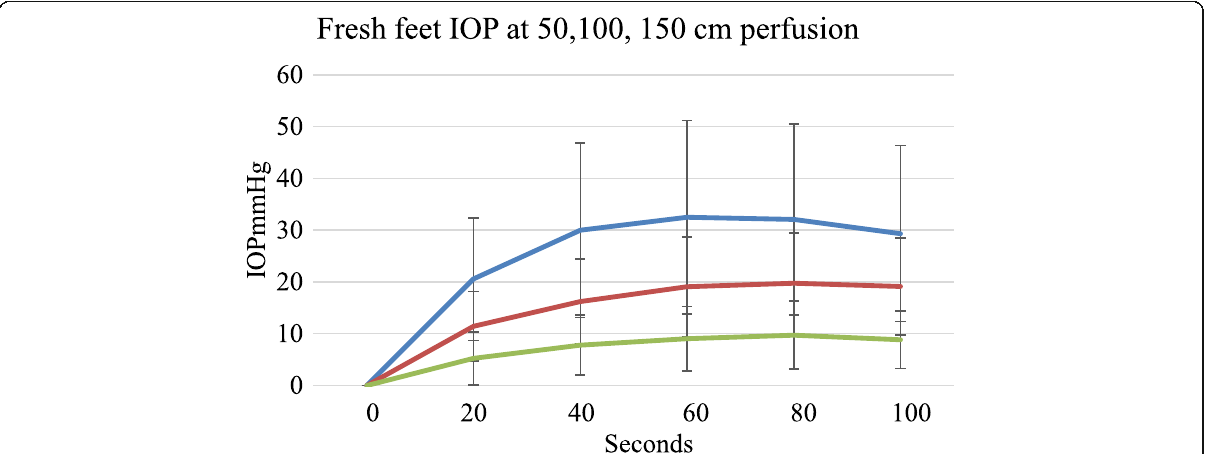
Fig. 5 For fresh feet IOP peaked at about 1 min with no further increase up to 100 seconds (t-test p = 0.4). Blue = 150 cm, Red = 100 cm, Green = 50 cm perfusion pressure, error bars